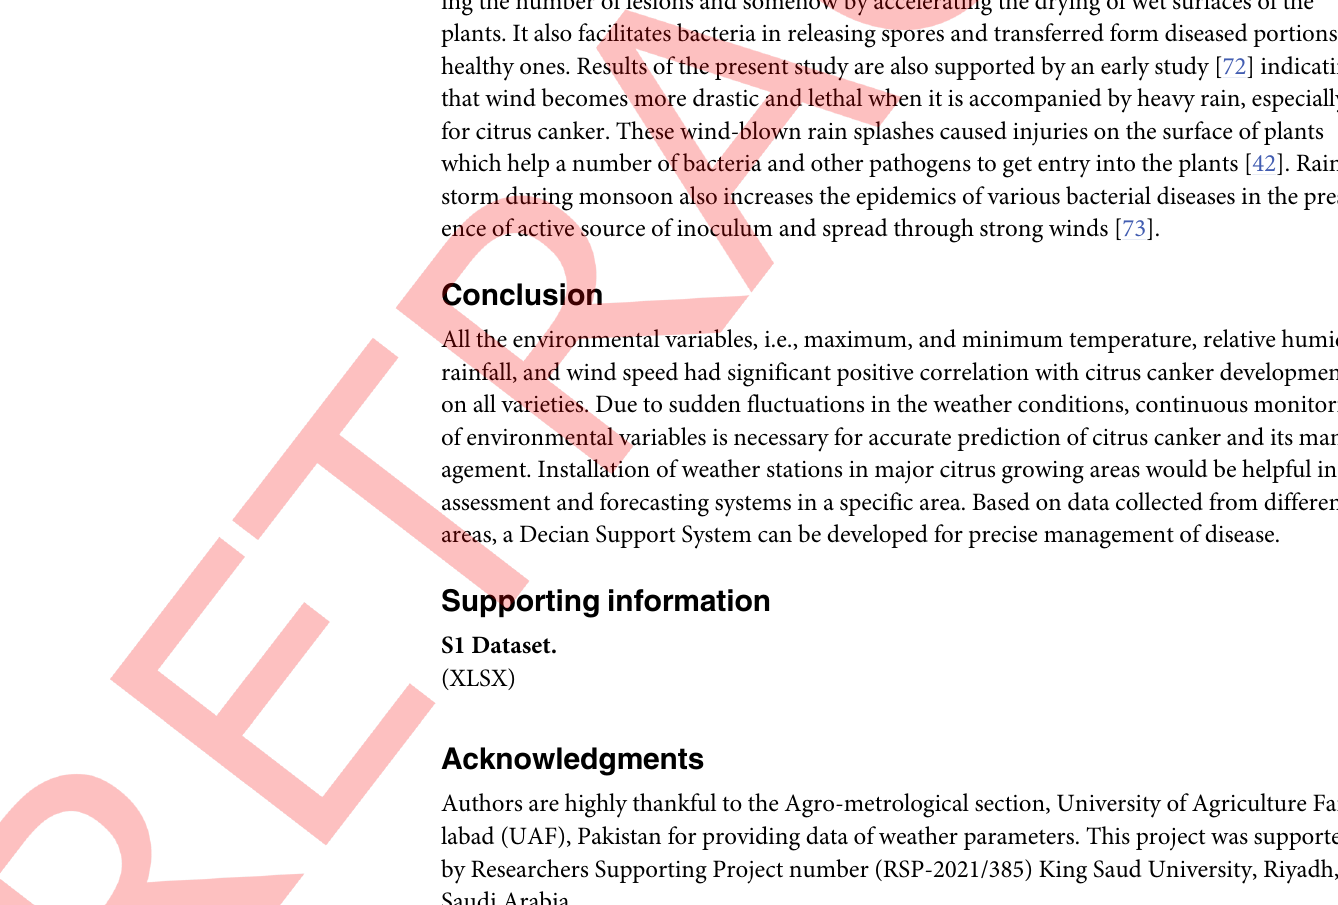
Fig 8. Relationship of wind speed with the development of citrus canker disease during 2017–18 (A) and 2018–19 (B).